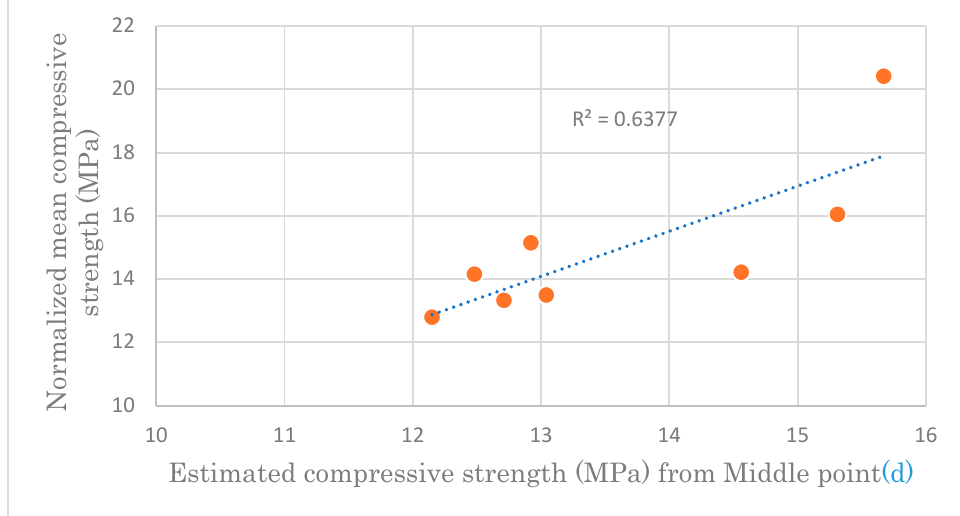
Figure 11 . Estimated versus normalized mean compressive strength. ( A ) Compressive strength at middle points (d); ( B ) Compressive strength at middle points (f).